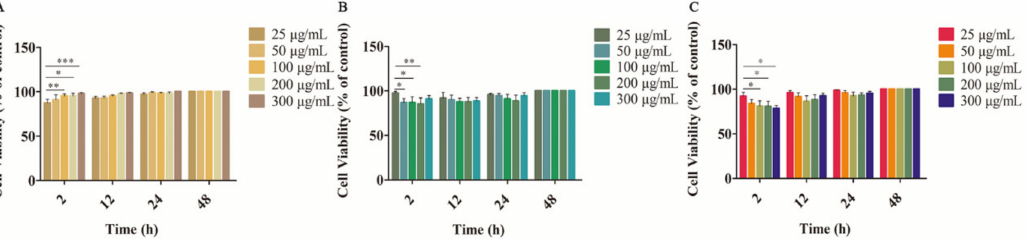
Figure 3. Cell viability of HOK cells after treatment with the PVA/CMC-Na blended film ( A ), lidocaine powder ( B ), and Li-HAMNs ( C ) (* p < 0.05, ** p < 0.01, *** p <